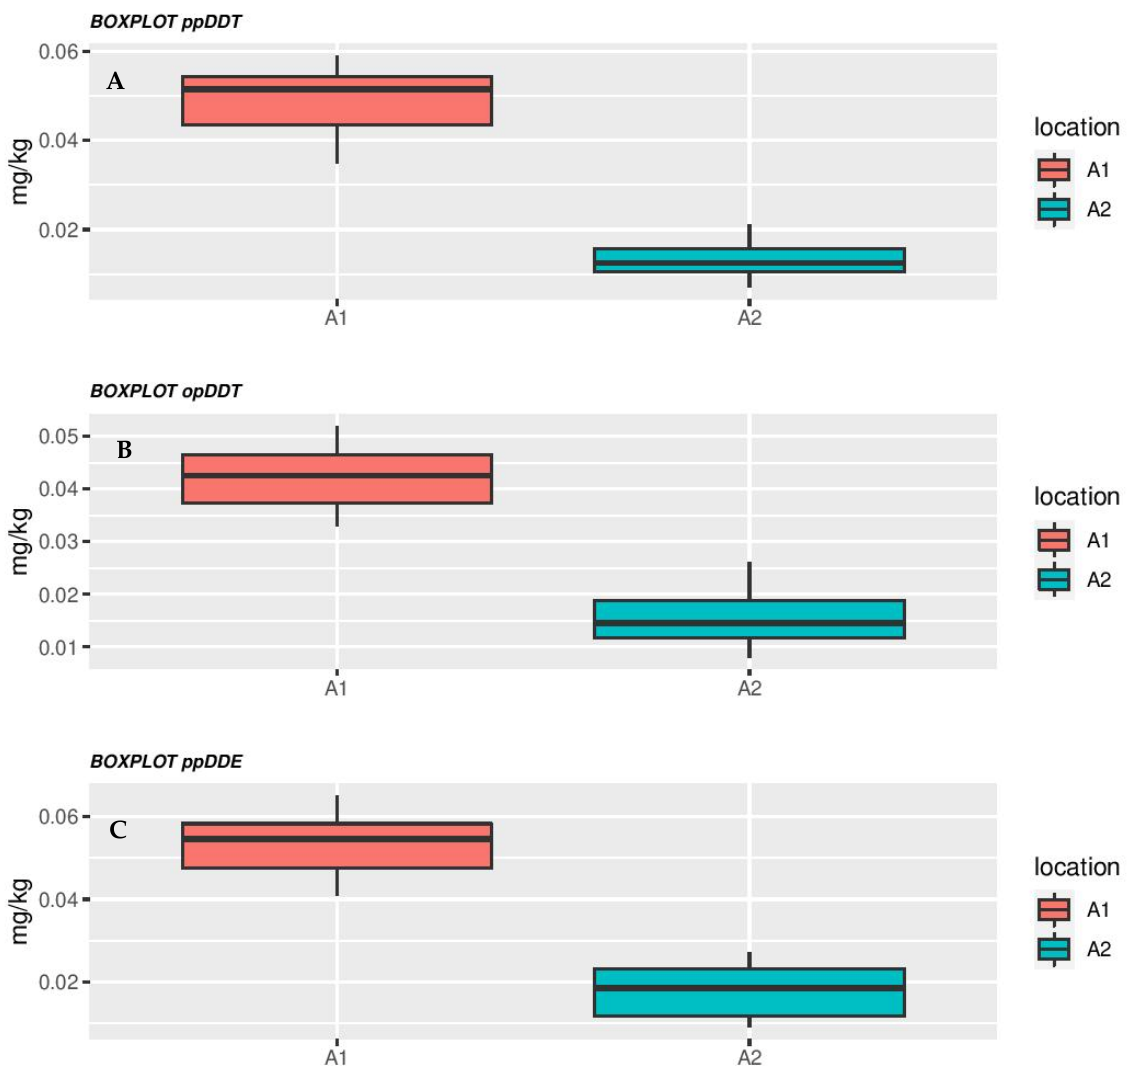
Figure 3. Pesticide level variations in soil samples from A1 area (industrial activity) and A2 area (agricultural activity): ( A ) p , p ’-DDT, ( B ) o , p ’-DDT and ( C ) p , p ’-DDE.